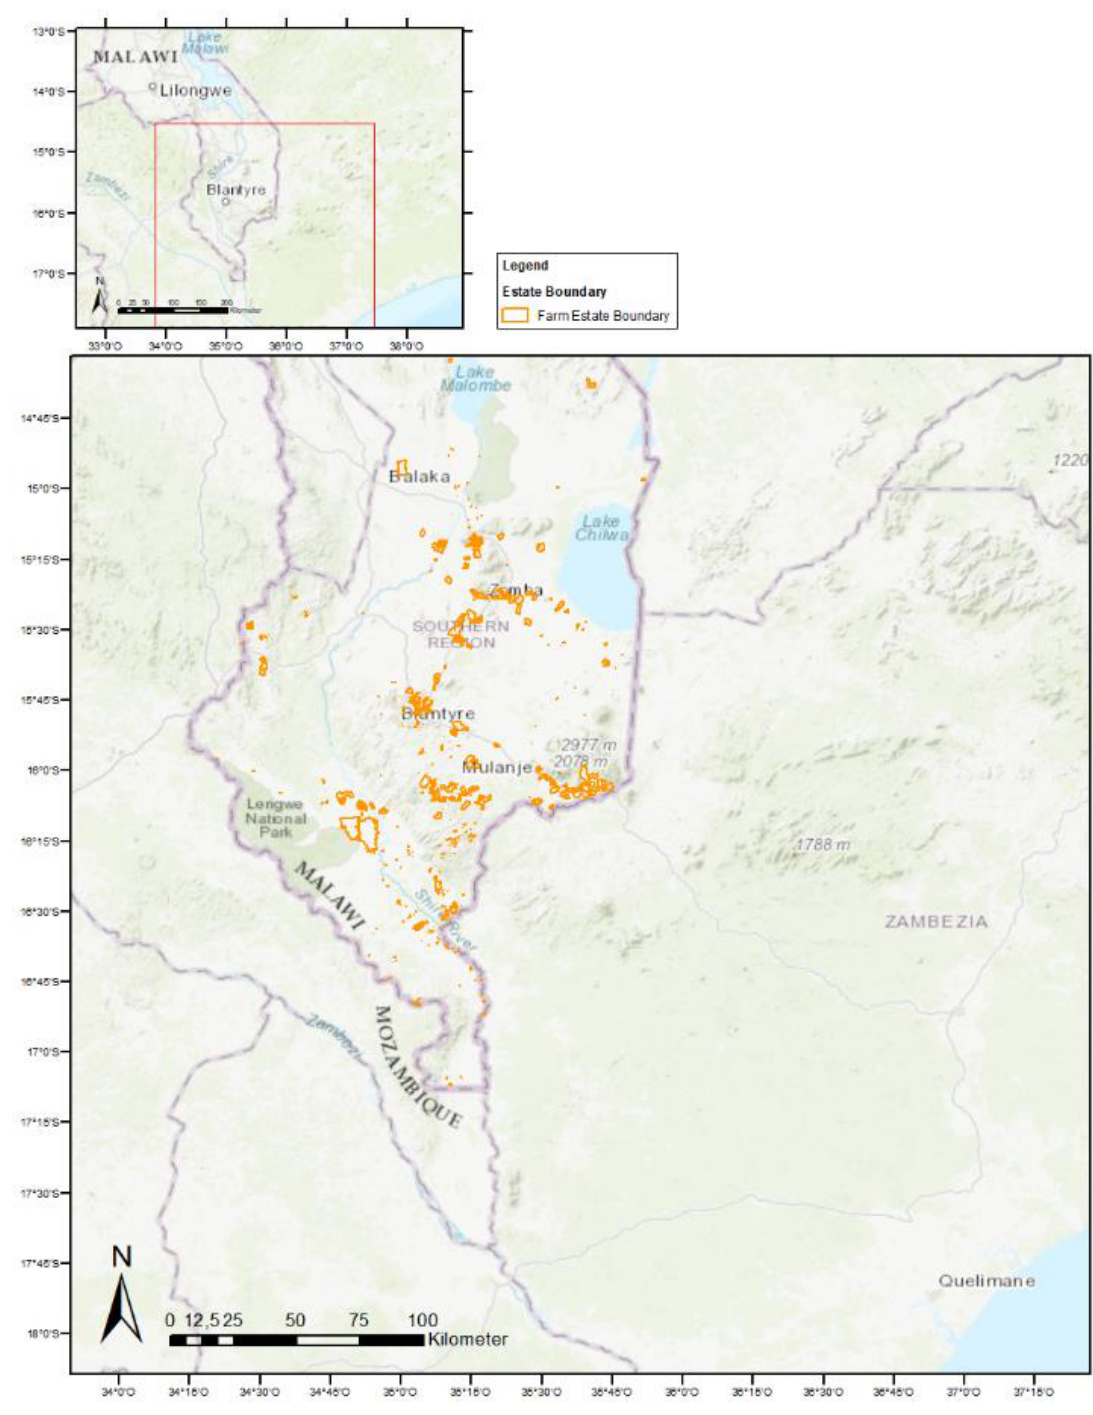
Figure 2. Map of the estate in Southern Malawi.